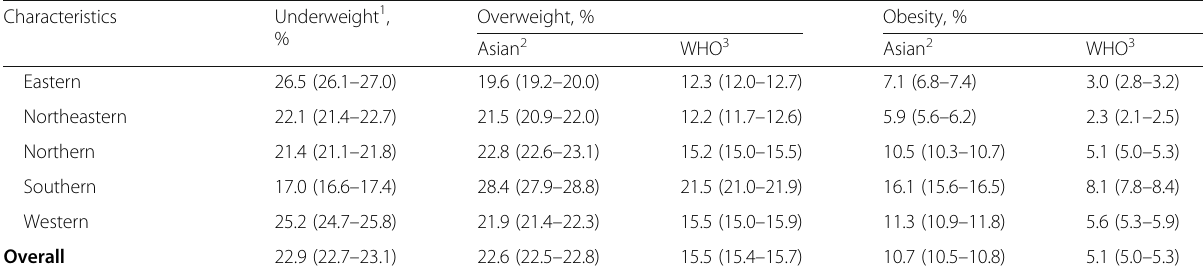
Table 2 Prevalence (with 95% CI) of underweight, overweight and obesity according to BMI categorization among women of